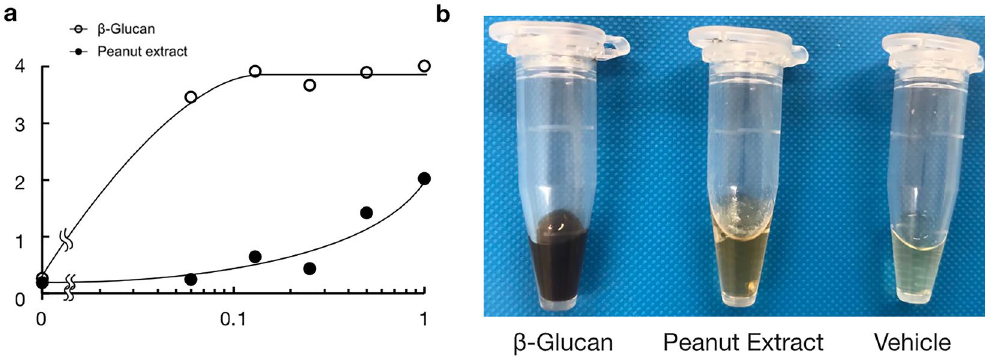
Figure 1. Melanization of hemolymph induced by peanut extract in silkworms. ( a ) The chart shows the dose- dependent melanin inducing effect of peanut oil in the silkworm. The y-axis represents the OD value (492 nm) of silkworm hemolymph was measured 3 h after sample injection. The x-axis represents the dose (mg/larva) of the peanut extract that was injected to the hemocoel of the silkworm. Mean values from duplicate measurements are shown in the chart. ( b ) Photo of the blackened hemolymph sample. Melanin formation was induced by injecting β-glucan (0.5 mg/larva) and the peanut extract (1 mg/larva)while the vehicle (saline) did not.